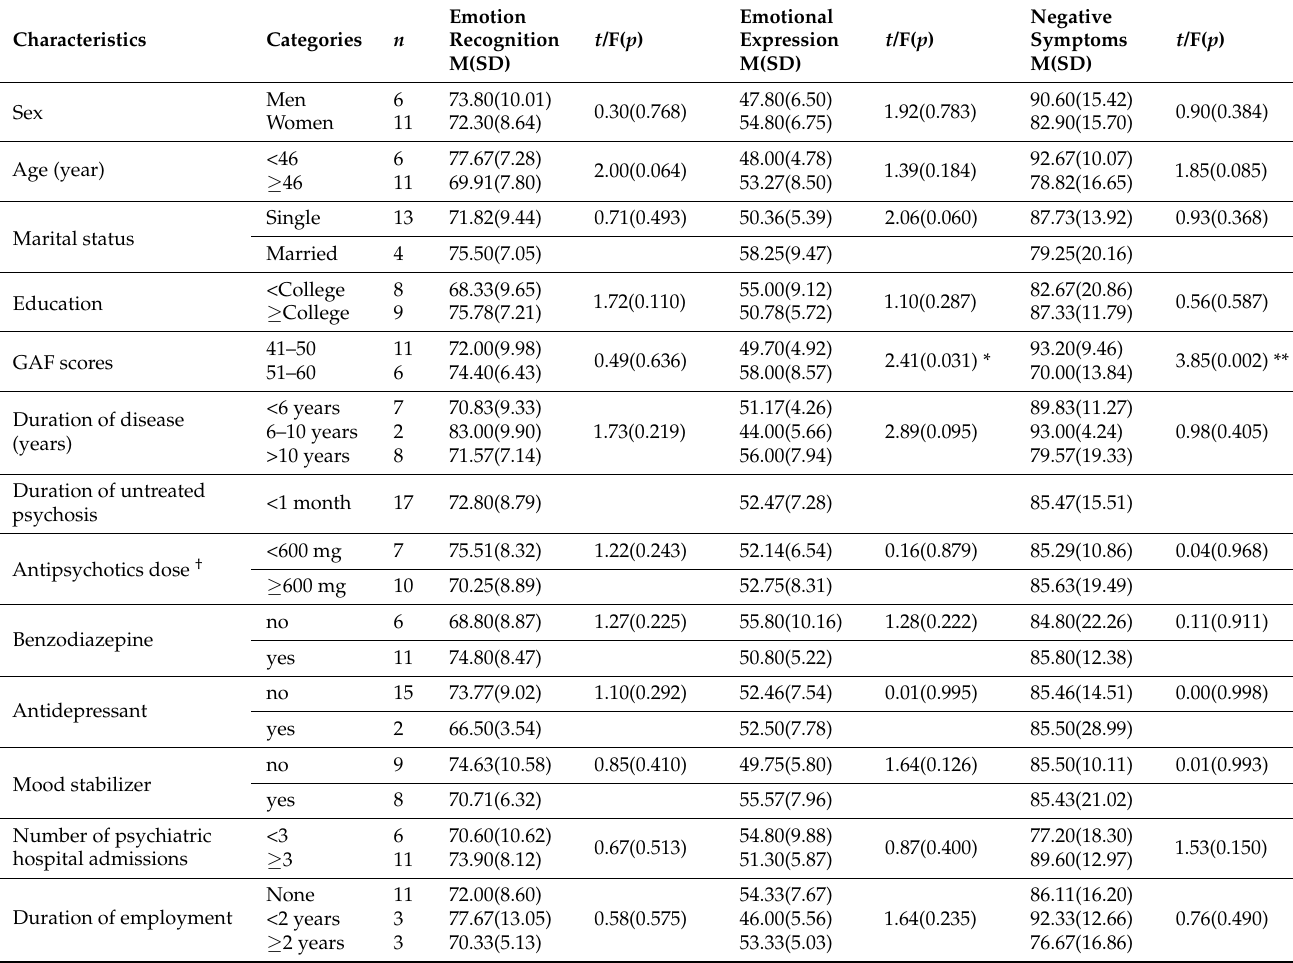
Table 3. Results for the comparisons between dependent variables and participants’ general and disease-related characteris- tics ( n =